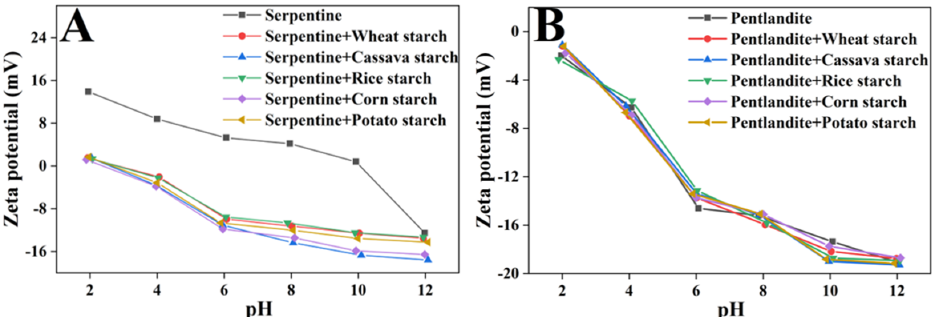
Figure 7. Zeta potentials of serpentine ( A ) and pentlandite ( B ) as a function of pH in the presence and absence of depressants (1 × 10 –2 g/L).